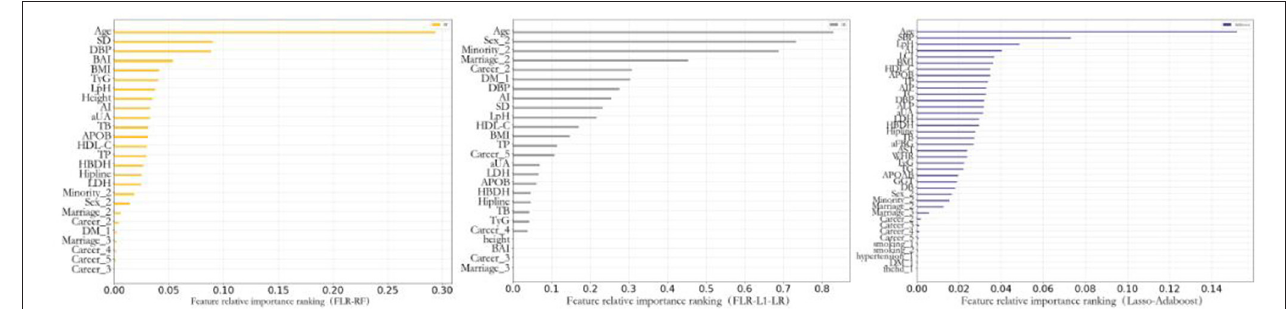
FIGURE 4 | Feature importance of included variables obtained from the random forest with forwarding Partial Likelihood Estimation (FLR-RF), L1 regularized Logistic regression with FLR (FLR-L1-LR), Lasso-AdaBoost model. SD, pulse pressure difference; DBP, diastolic blood pressure; BAI, body obesity index; BMI, body mass index; TyG, triglyceride blood glucose index; LpH, low-high-density lipoprotein ratio; AI, arteriosclerosis index; aUA, uric acid; TB, total bilirubin; APOB, apolipoprotein B; HDL-C, high-density lipoprotein cholesterol; TP, total protein; HBDH, α -hydroxybutyrate dehydrogenase; LDH, lactate dehydrogenase; SBP, systolic blood pressure; LCI, blood lipid index; AIP, Plasma arteriosclerosis index; TC, total cholesterol; ALP, alkaline phosphatase; aFBG, fasting blood glucose; AST, aspartate aminotransferase; WHR, waist-to-height ratio; APOAB, apolipoprotein AB; GGT, γ -glutaminase; DB, Direct Bilirubin; DM, diabetes mellitus; Fhchd, Family history of coronary heart